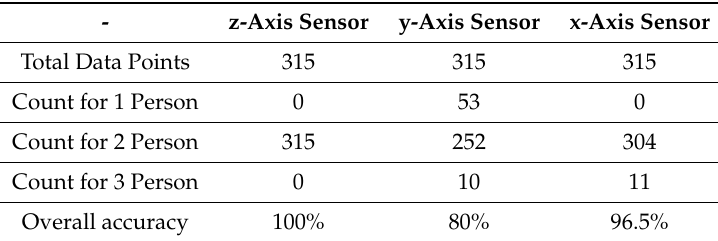
Table 5. Connected component: two people sitting.